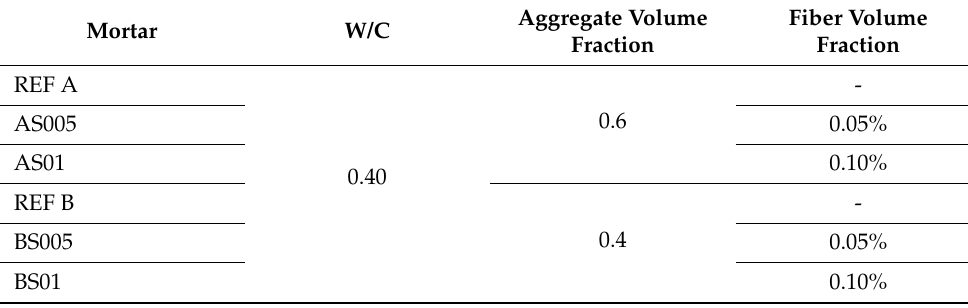
Table 1. Mortar designations and mixture proportions.